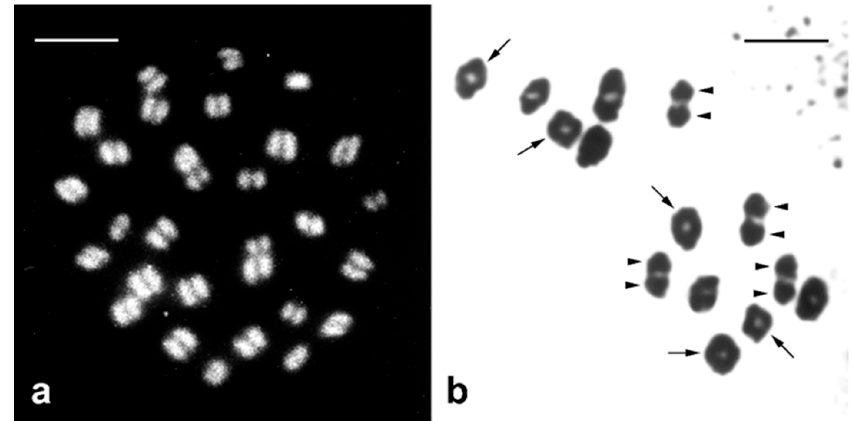
Figure 2. Comparison of female and male meiotic chromosomes in Lepidoptera. ( a ) Female metaphase I bivalents ( n = 30) of the Mediterranean flour moth, Ephestia kuehniella Zeller, stained with DAPI (white). Each bivalent consists of two homologous chromosomes arranged parallel to each other; the proteinaceous structure of the modified synaptonemal complex (SC) forms an unstained gap between the two homologues. ( b ) Male metaphase I bivalents ( n = 14) of the vaporer, Orgyia antiqua (L.), stained with lactic acetic orcein. Two homologous chromosomes are maintained in bivalents by chiasmata; two arrowheads indicate two homologues of bivalents with one chiasma, arrows indicate bivalents with two chiasmata. Bar = 5 µm.